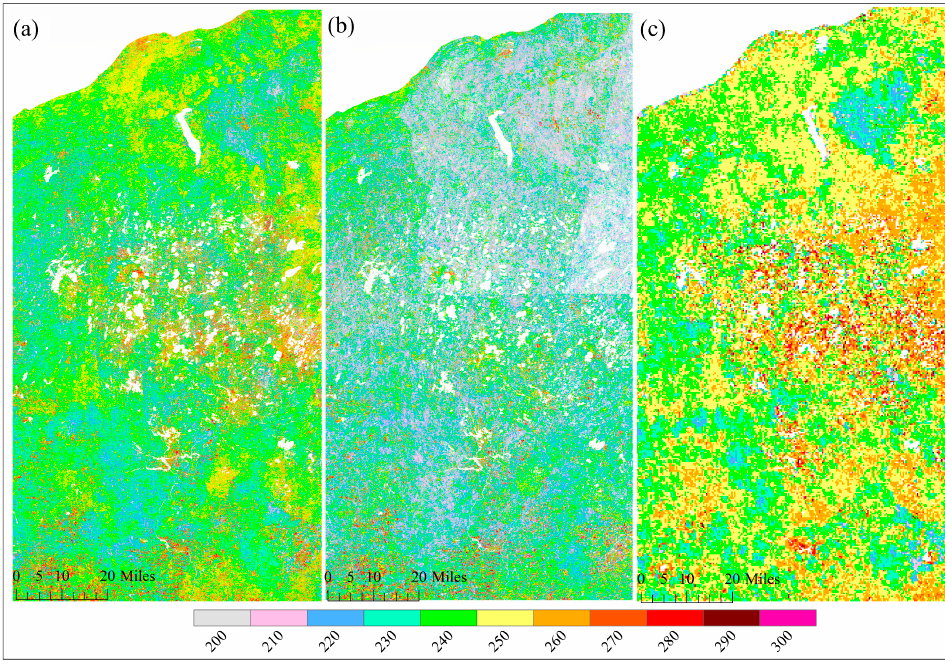
Figure 6. Spatial pattern of senescence onset from ( a ) HLS-ABI, ( b ) HLS, and ( c ) ABI data in the study area.